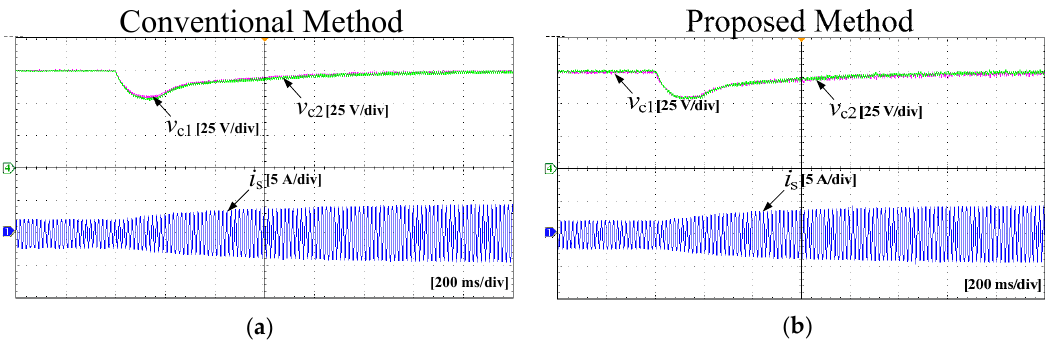
Figure 23. Experimental results of capacitor voltages ( v c1 , v c2 ) and source current with step change of load resistor from 200 Ω to 100 Ω obtained by ( a ) conventional method and ( b ) proposed method.